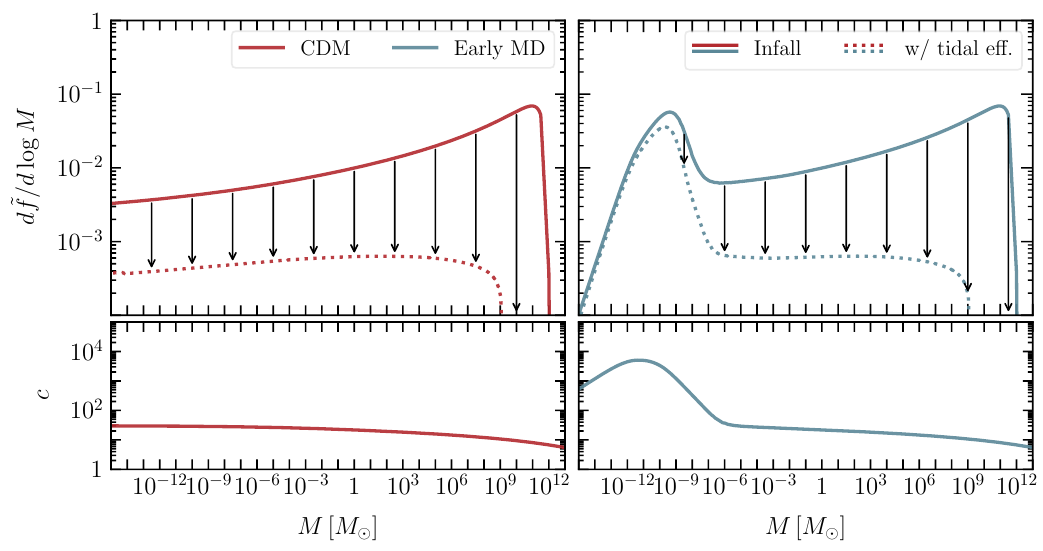
Figure 4 . Illustrative example of the impact of tidal effects on the subhalo mass fraction. Upper : subhalo mass fraction before (solid) and after (dotted) tidal disruption for standard Λ CDM (red), and early MD (blue) with reheating temperature T = 10 MeV (for more details see section 4.3). RH Lower : typical concentration parameter as a function of the subhalo mass. Additional power on small scales leads to an early collapse and therefore a larger concentration parameter for light